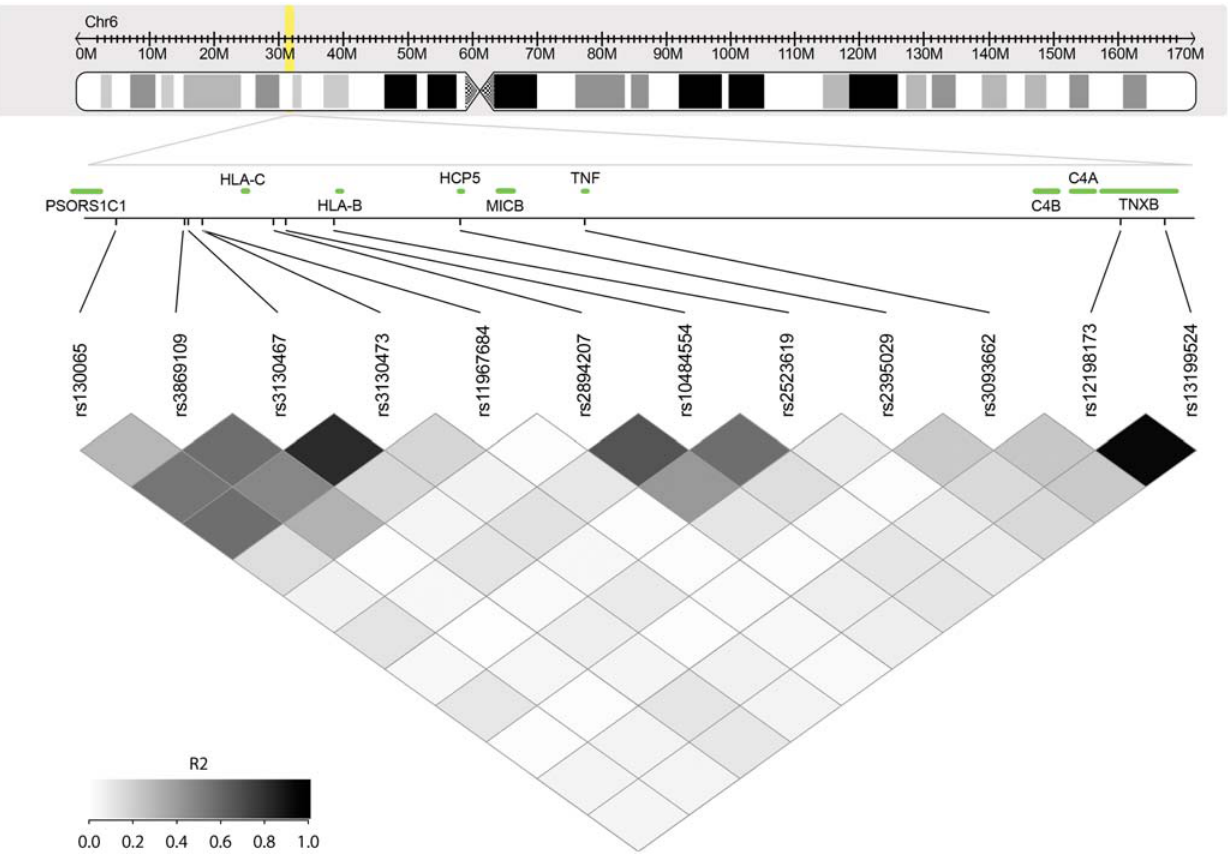
Figure 2. Location of the twelve selected SNPs in the MHC region (6p21) and linkage disequilibrium plot. Upper box shows an ideogram depicting chromosome 6 and the annotated region (transparent yellow rectangle). Lower box shows the linkage disequilibrium data matrix calculated from the European HapMap population. The colour intensity of each box is proportional to the strength of the LD property (r 2 ) for the marker pair.